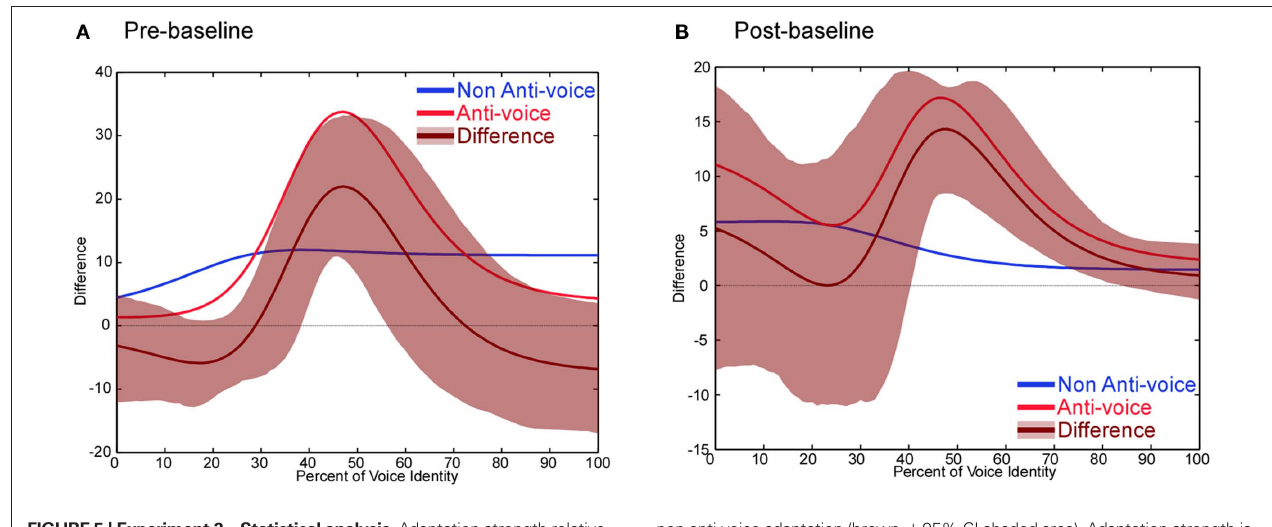
non-anti-voice adaptation (brown, ± 95% CI shaded area). Adaptation strength is computed by calculating the difference between the adaptation condition and